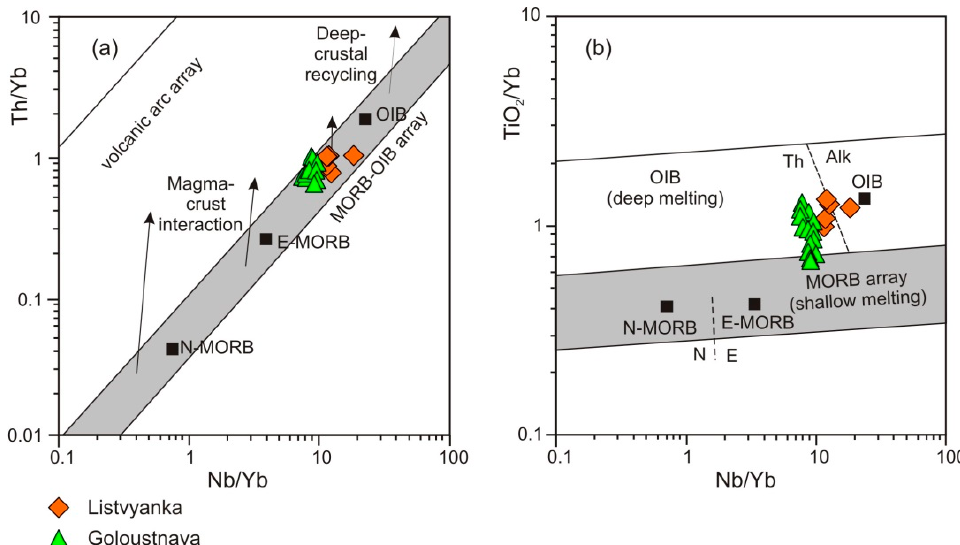
Figure 11. Th/Yb–Nb/Yb ( a ) and TiO 2 /Yb–Nb/Yb ( b ) diagrams [39] for Listvyanka and Goloustnaya dolerites. Abbreviations: N-MORB, normal mid-ocean ridge basalts; E-MORB, enriched mid-ocean ridge basalts; OIB, oceanic island basalts; Th, tholeiitic OIB; Alk, alkalic OIB.